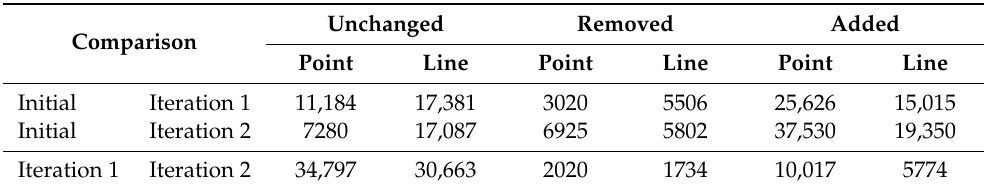
Table 2. Comparison between the number of unchanged, removed and newly added objects in the entire dataset at different steps of the re-annotation pipeline.